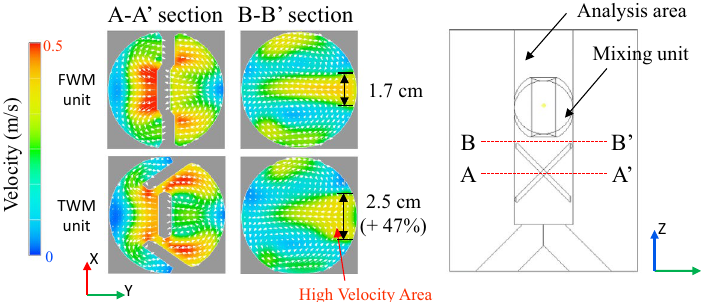
Figure 3. Velocity distribution of the FWM unit and the TWM unit; by comparing each section ② of the FWM unit and the TWM unit, a high-velocity area appears in the middle part of the TWM unit (47% larger than that of the FWM unit). It means the TWM unit has a higher recombination function than the FWM